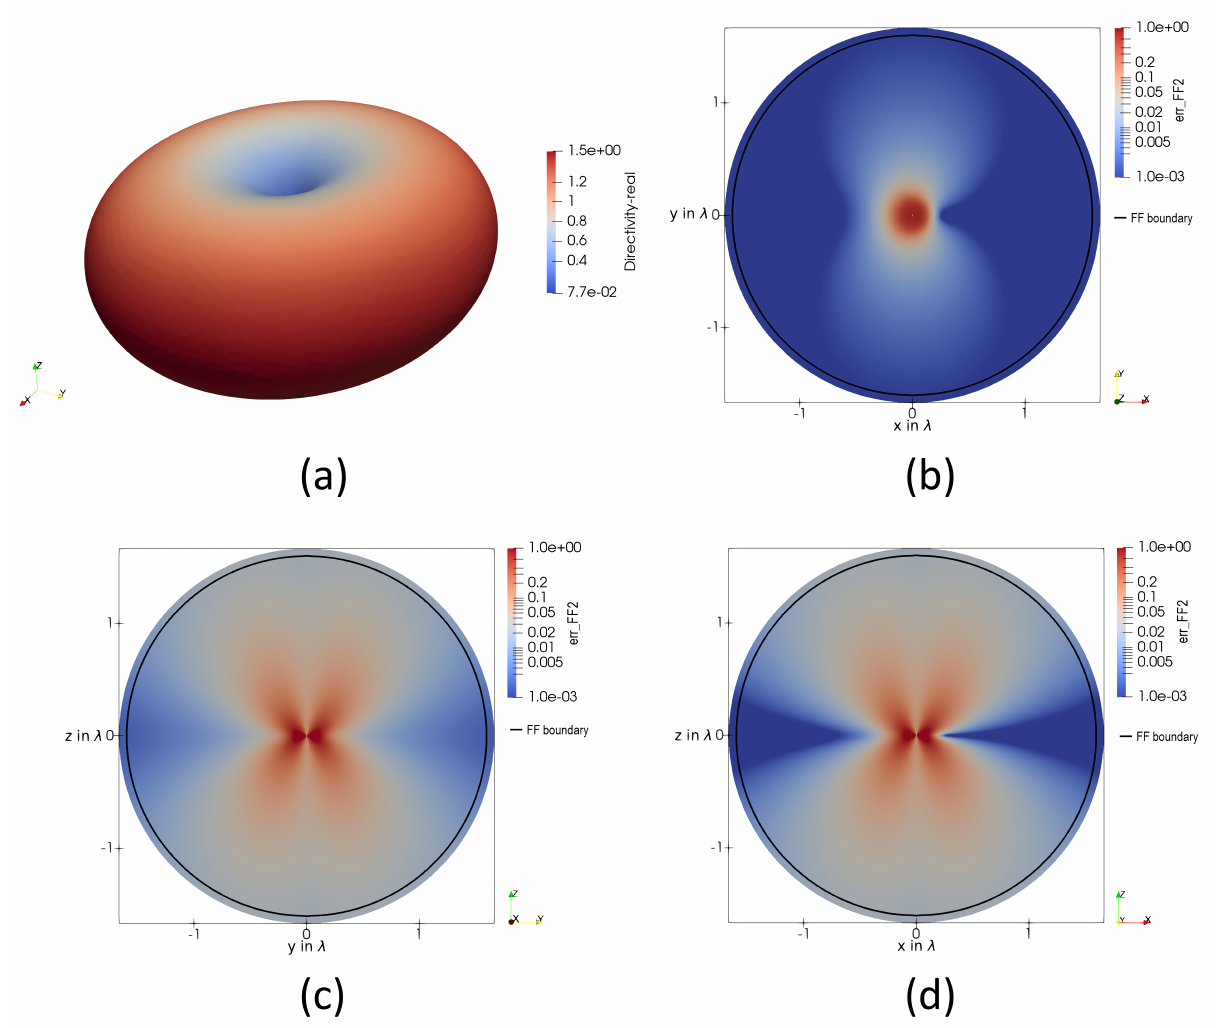
Figure 18. ( a ) A 3D plot of the directivity D ( θ , φ ) of a loop antenna with the circumference of C = 0.01 λ . The error-estimator 6, describing a qualitative measure of the FF quality, applied on a loop antenna with the circumference of C = 0.01 λ in the ( b ) xy-plane, ( c ) yz-plane, and ( d ) zx-plane. The FF boundary r far for the given antenna dimension l = C given in 4 is displayed as a black π